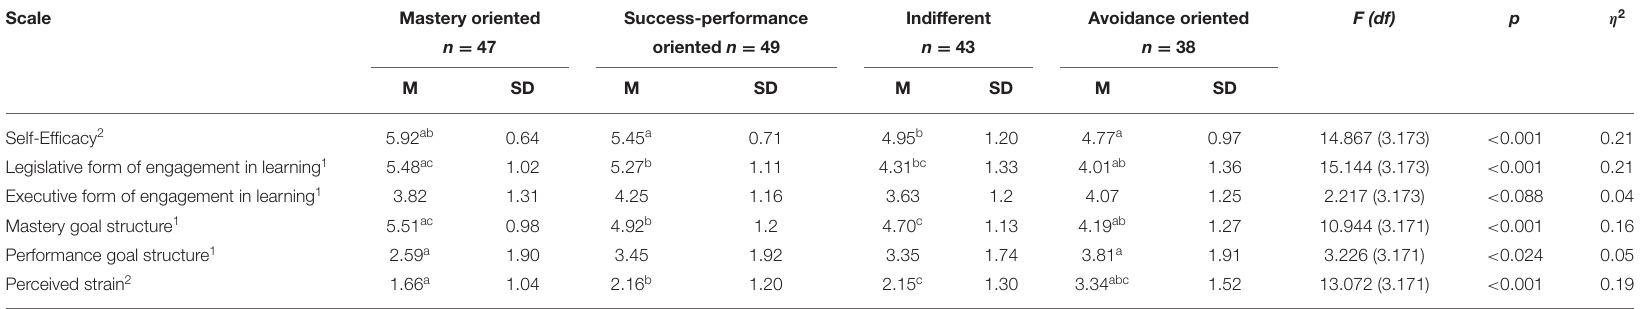
TABLE 4 | Mean differences on self-efficacy, preferred forms of engagement in learning, and classroom goal structures between goal-orientation groups.